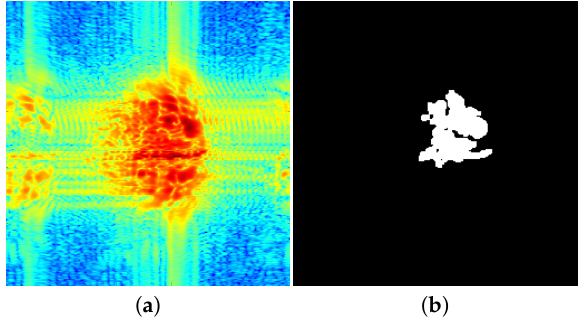
Figure 24. Example of image of knife: ( a ) RGB mmW scan; ( b ) Segmented image.